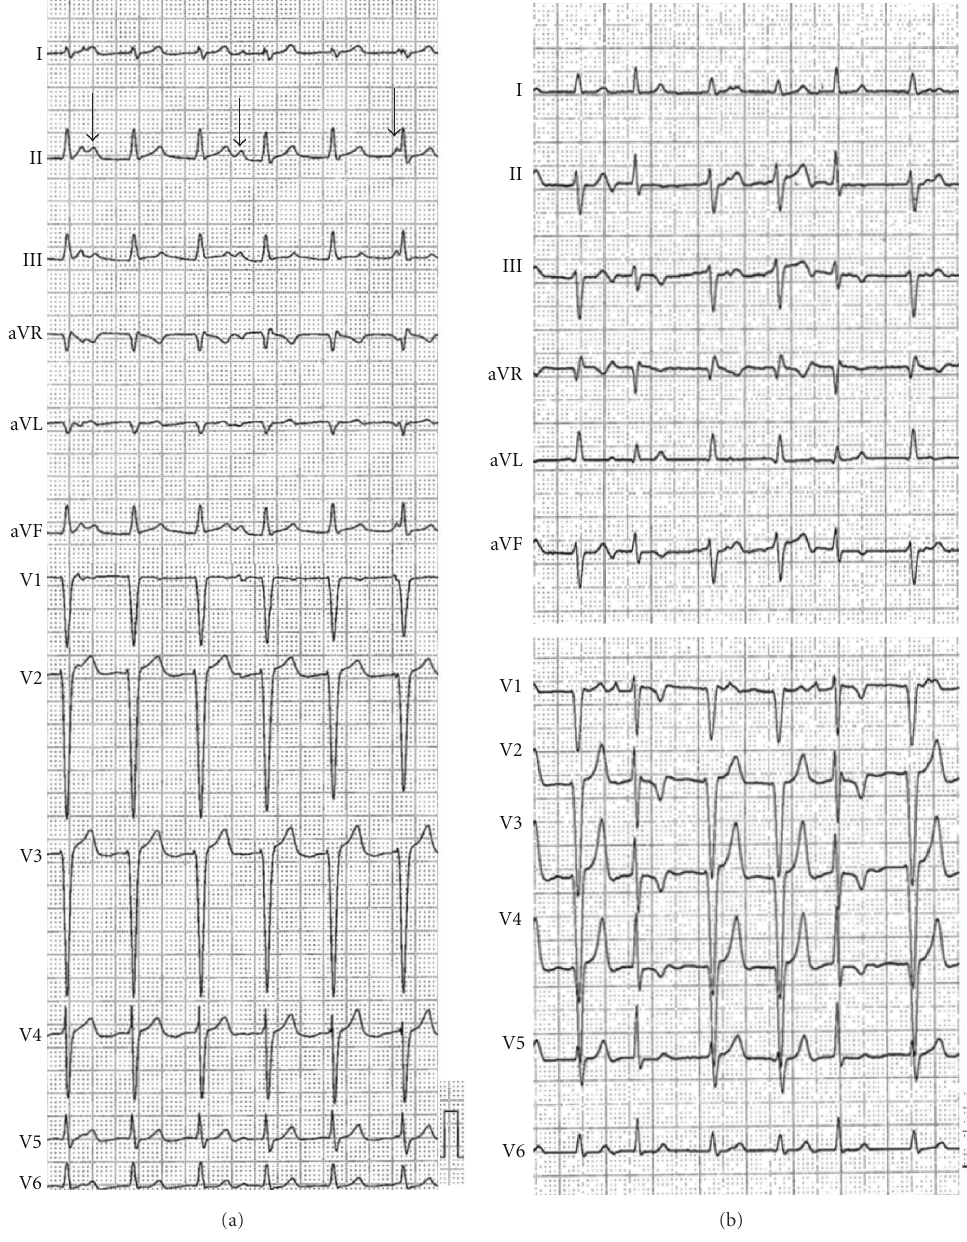
Figure 1: (a) The baseline 12-lead electrocardiogram (ECG) in the supine position shows accelerated idioventricular rhythm (AIVR) without atrioventricular conduction. The arrows indicate the P wave. (b) The ECG in the standing position immediately after exercise. The waveforms of limb leads in the standing position di ff er from those in the supine